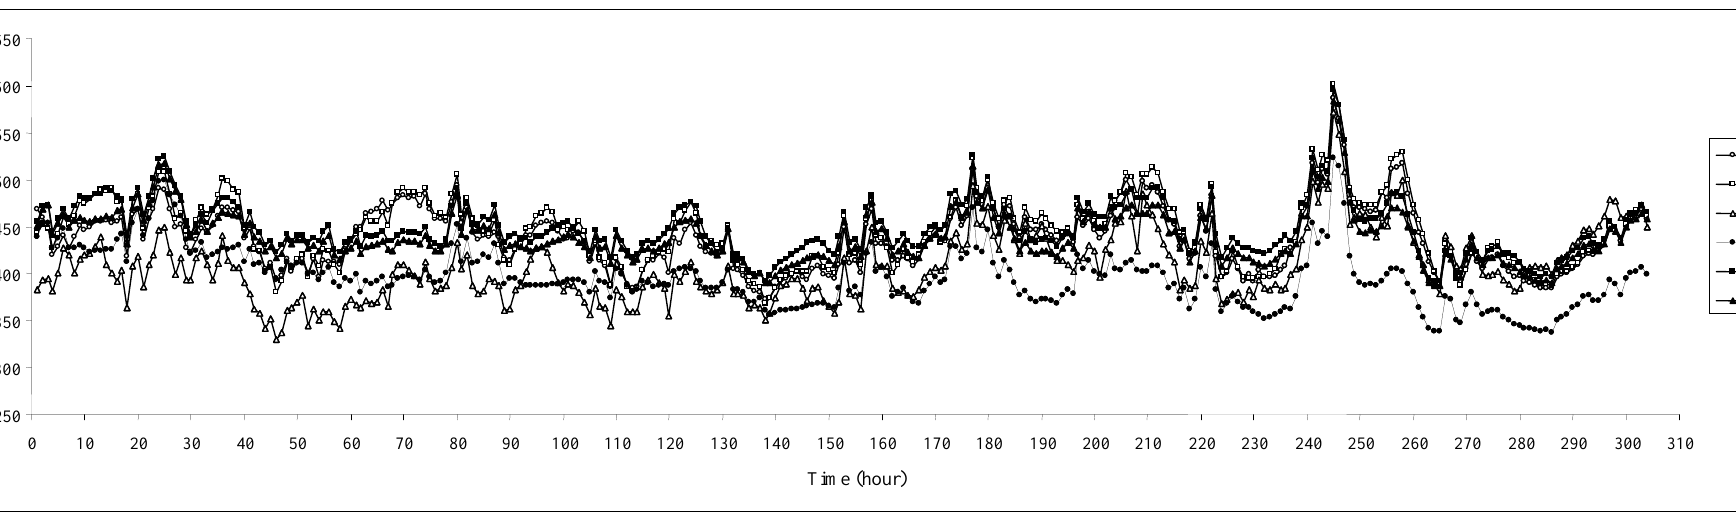
measured simultaneously by 6 CO 2